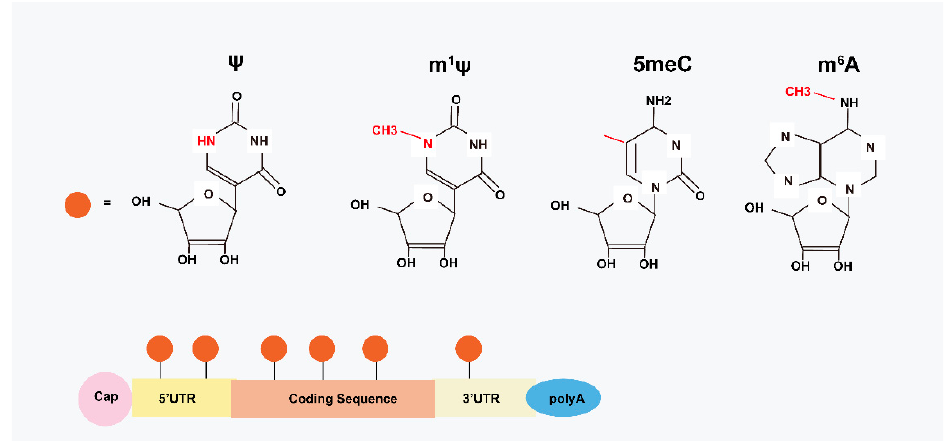
Figure 1. Structural basis of modRNA. Modified mRNA-based therapy by chemically modified nucleotides, including insertion of methyl or hydroxylate groups and replacement of uridine with ψ .